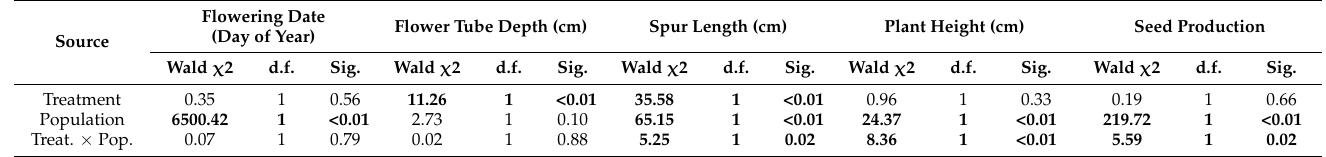
Table 1. Effects of treatment (netting and control), population (low selfing rate and high selfing rate), and their interaction on the flower date, flower tube depth, spur length, plant height, and seed production using a generalized linear model in Halenia elliptica . Significant effects are shown in